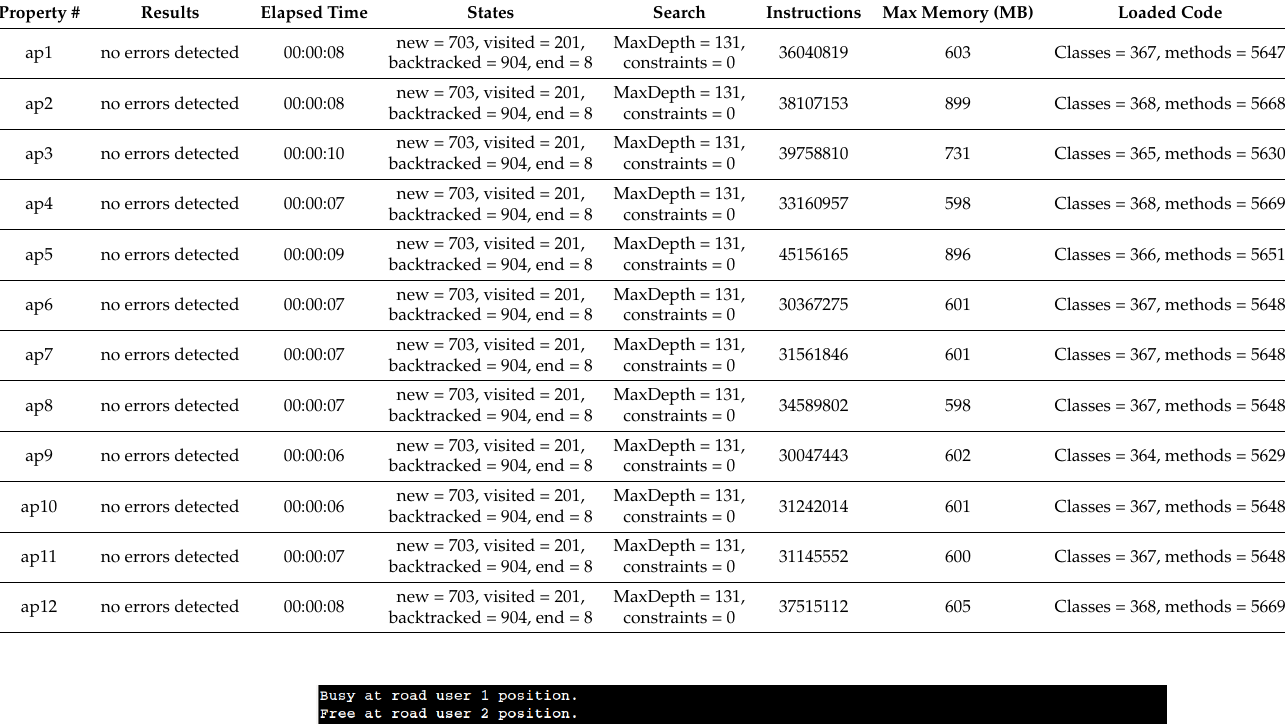
Table 6. Properties verified with AJPF —Execution results.